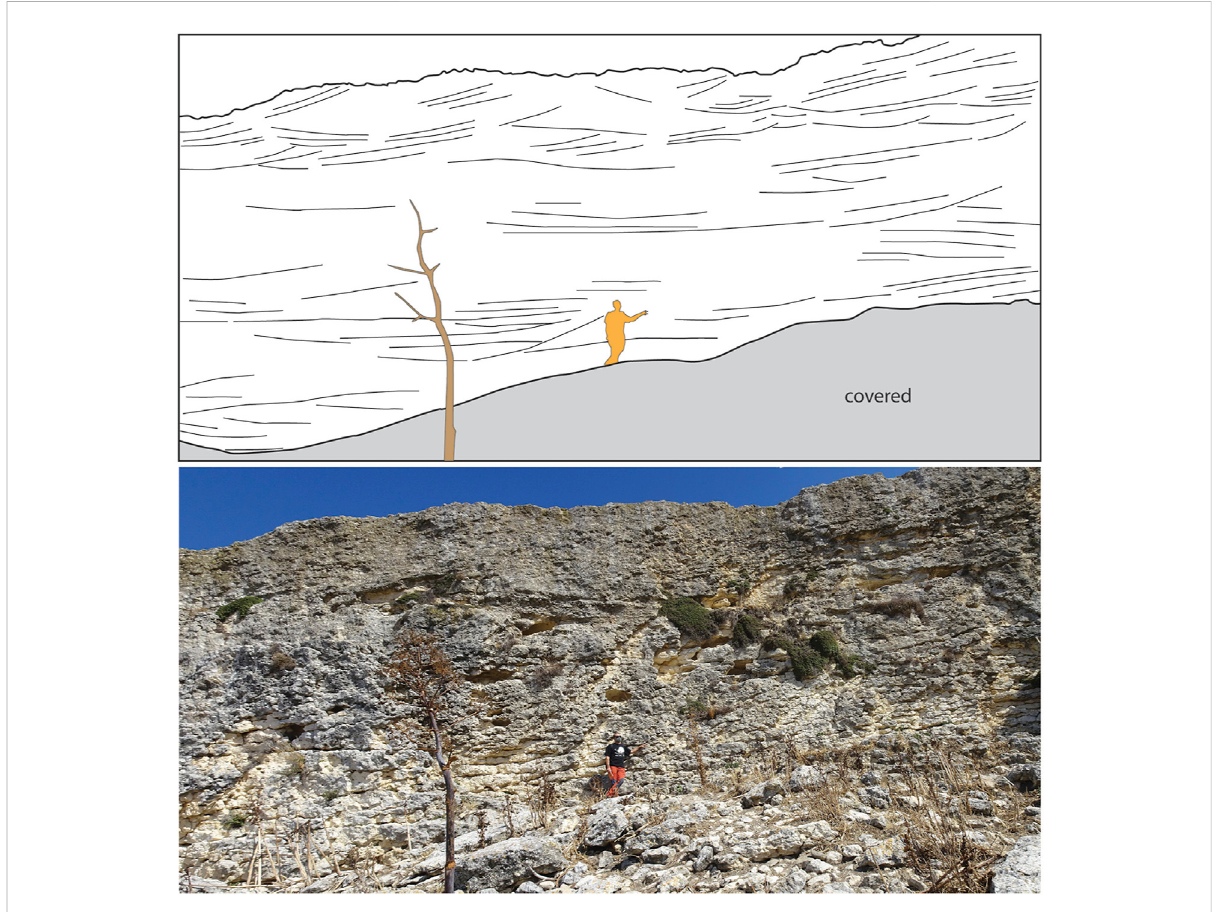
FIGURE 4 View of the trough cross-bedded rhodolith rudstone between Sections 1, 2. The drawing in the upper panel remarks the most outstanding bedding surfaces. Note the poorly de fi ned cross-bedding with most troughs pointing to the north (into the wall and to the